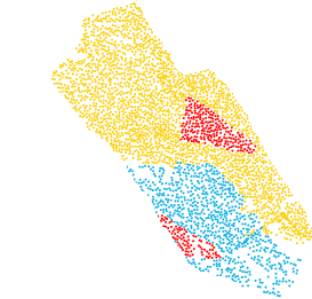
Figure 6. Results of seed selection (Seeds are marked in